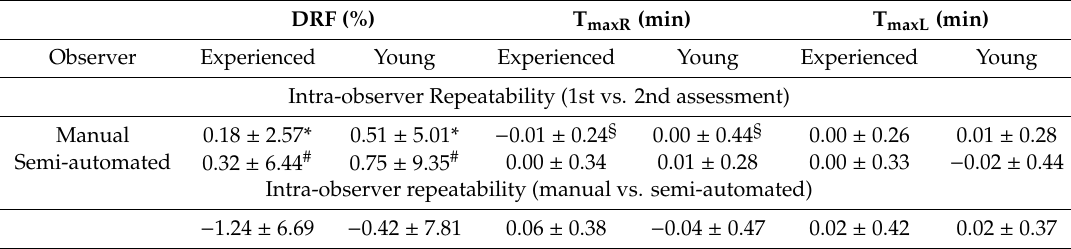
Table 4. Intra-observer repeatability data for DRF, T maxR and T maxL according to the Bland–Altman analysis (mean ± 1.96 SD of the di ff erences).